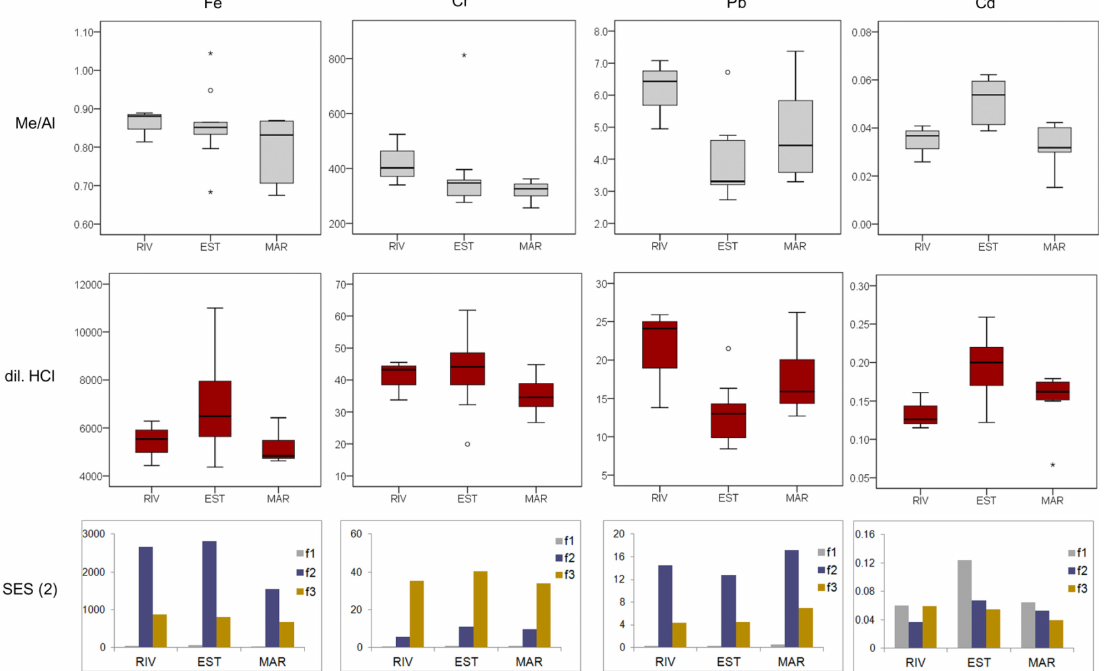
Figure 12. Distributions of Me to Al ratios (except for Cr) in the upper panel, of the concentrations of labile metal fractions (in mg/kg) extracted by 0.5 N HCl (dilute HCl) in the middle panel and by SES (2) (in mg/kg) in the lower panel in the riverine (RIV), estuarine (EST) and marine (MAR) sector of the Asopos system. In the box plots, the boxes contain the middle 50% of the data; the lower hinge (edge of the box) represents the 25th percentile and the upper hinge the 75th percentile; the horizontal line within the box is the median value; whiskers show the range of values falling within 1.5 times the H-spread, which is defined as the difference between the hinges; in the absence of outliers, whiskers represent the minimum and maximum data values; outliers are denoted with circles and are defined as the values between 1.5 and 3 times the H-spread; extreme values are denoted with asterisks and are defined as the values > 3 times the H-spread. In the lower panel, f1, f2 and f3 are the acid soluble, the reducible and the oxidizable fractions,